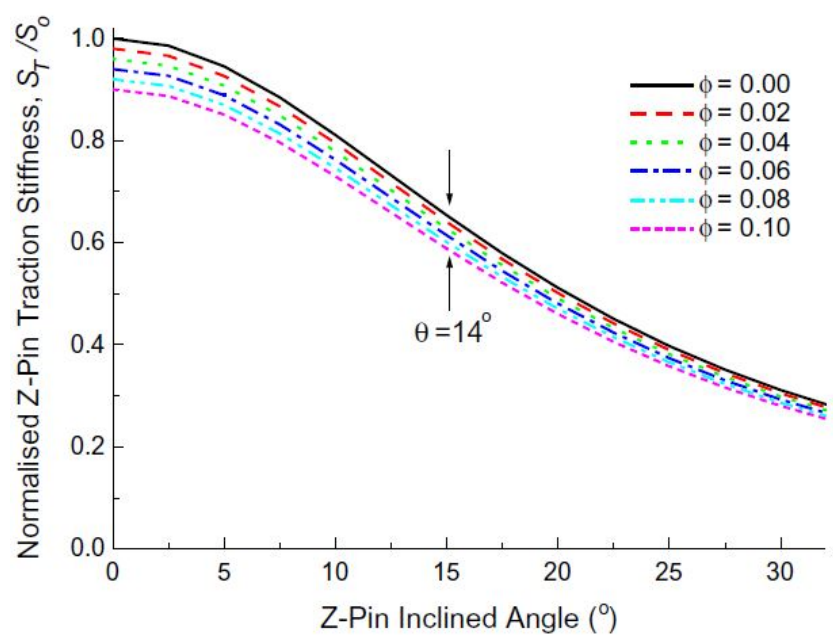
Figure 20. E ff ect of z-Pin o ff set angle ( θ ) and void content ( ϕ ) on the normalized z-Pin traction F igure 20. Effect of z-Pin offset angle ( θ ) and void content ( φ ) on the normalized z-Pin traction sti ff ness [13]. stiffness [13].